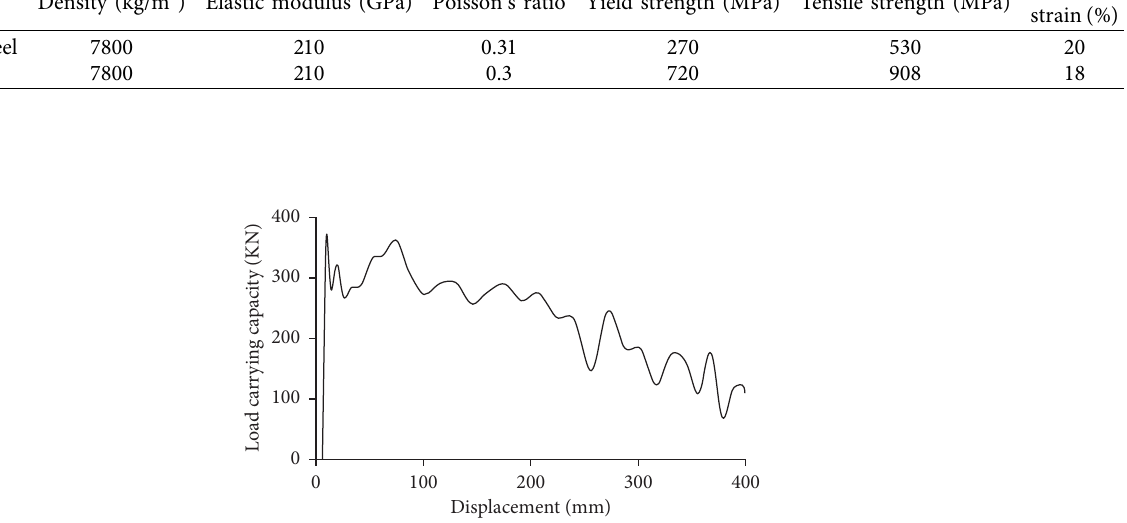
Figure 9: Bearing capacity changing curve of retractable O -shed stent under concentrated impact